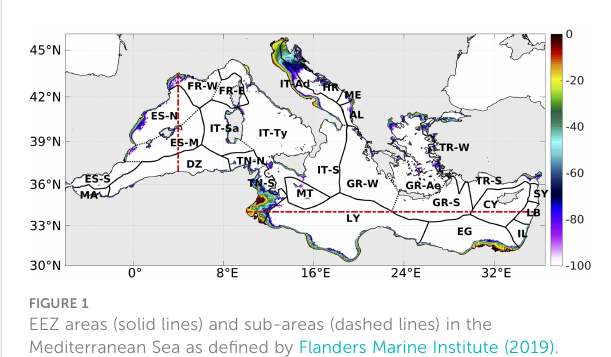
FIGURE 1 EEZ areas (solid lines) and sub-areas (dashed lines) in the Mediterranean Sea as de fi ned by Flanders Marine Institute (2019). The two sections at [37-43°N; 4°E] and [34°N; 10-36°E] (red lines) will be used in Section 3. Bathymetry shallower than 100 m (in m) is indicated (in